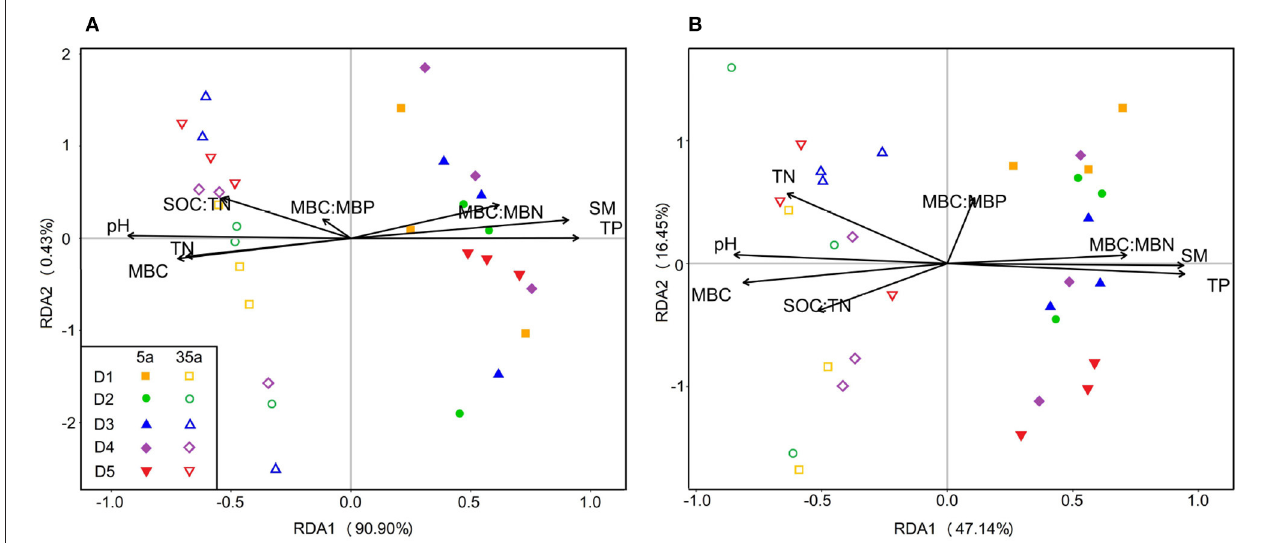
FIGURE 6 | Ordination plots of the results from the redundancy analysis (RDA) to identify the relationships between bacterial (A) or fungal (B) communities and microbial biomass and soil physicochemical properties (black arrows) in 5-year-old (closed symbols) and 35-year-old (open symbols) plantations. BG, β -glucosidase; LAP, leucine aminopeptidase, NAG, β -1,4-N-acetylglucosaminidase; AP, acid phosphatase; MBC, microbial biomass carbon; MBN, microbial biomass nitrogen; MBP, microbial biomass phosphorus; SM, soil moisture; SOC, soil organic carbon; TN, total nitrogen; TP, total phosphorus; B, bacteria; F,